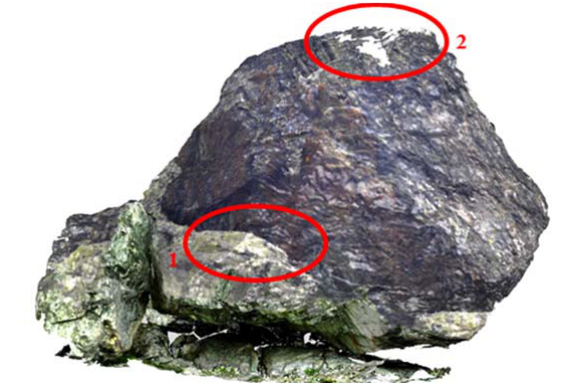
Figure 16: Fusion of Boulder Point Clouds 1: Radiometric Differences, 2: Holes on Boulder’s